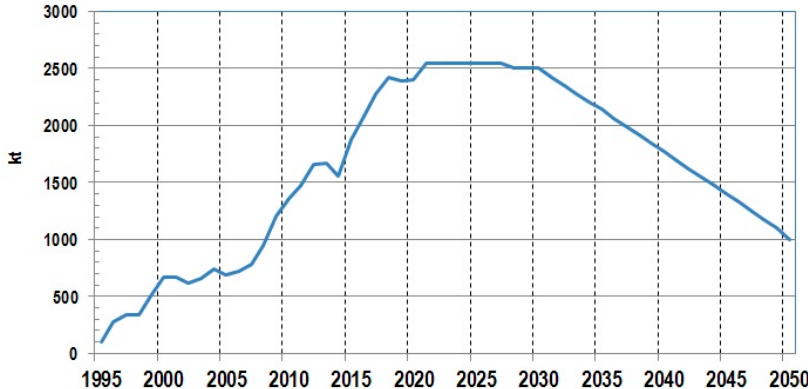
Figure 2. Forecast of limestone sorbents consumption for flue gas desulphurisation by wet limestone method in the years 2020–2050 (maximum expected forecasted quantities).